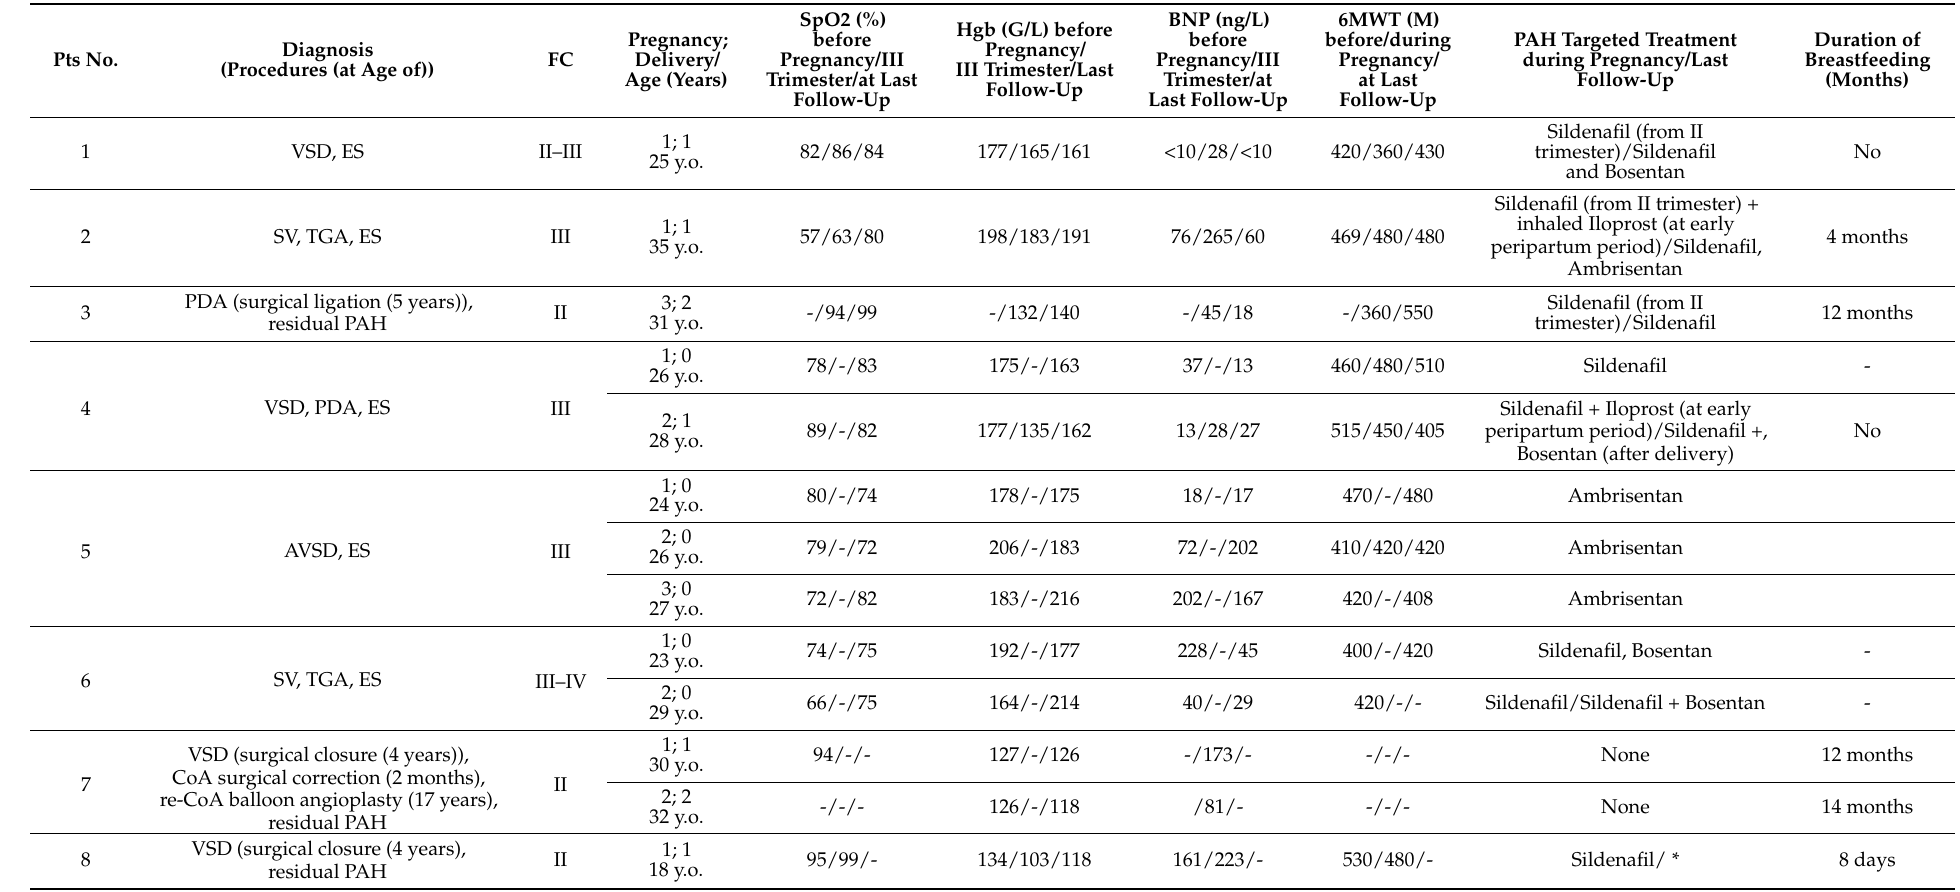
Table 1. Summary of patients’ baseline characteristics, management, and